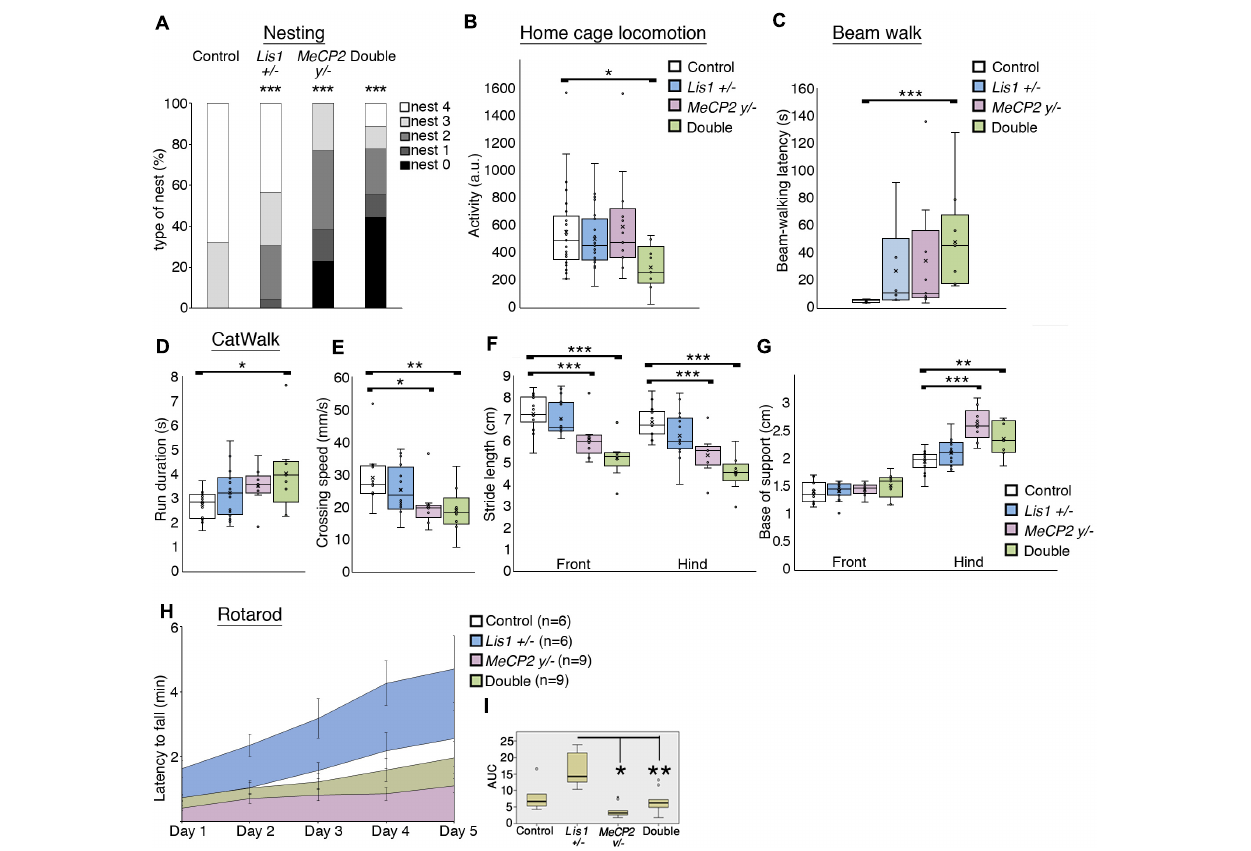
FIGURE 3 | LIS1-MeCP2 interaction, implications on adult brain. (A) The degree of nest building was assessed on a scale of 0 – 4 (Deacon, 2006). Nesting ability is presented in the distribution graph. Both the single and the double mutants exhibited impaired nesting ability. (B) The mean locomotion activity during the dark (active) diurnal phase is presented. The double mutant mice were significantly less active than the WT mice during the dark phase. (C) The mean latency to cross the beam in the balanced beam test is presented. The double mutant mice exhibited a significant higher latency to cross over. (D–G) CatWalk parameters are presented. (D) The mean run duration, double mutants differed from WT. (E) Mean speed, the double mutant and the MeCP2 cKO mice were significantly slower than the WT. (F) The stride length of front paws (on left) and the hind paws (on right) are presented. Stride length of both hind and front paws of the MeCP2 cKO and the double mutant was shorter than that of WT mice. (G) The base of support (BOS) of front paws (left) and the hind paws (right) are presented, the hind paws BOS of the MeCP2 cKO and the double mutant mice was higher as compared to WT. (H,I) The latency to fall in the rotarod test is presented. (H) The latency to fall over different days is presented. (I) Comparison between the different genotypes. Heterozygotes Lis1 exhibited significant increased latency to fall as compared with MeCP2 cKO and double mutants mice. Data are shown in (B–G) , and (I) as Box plots [box = 25, 50 (median), 75 percentiles; whiskers = 5–95 percentiles] and (H) as mean ± SEM. ∗ p < 0.05, ∗∗ p < 0.01, ∗∗∗ p < 0.001, as compared with